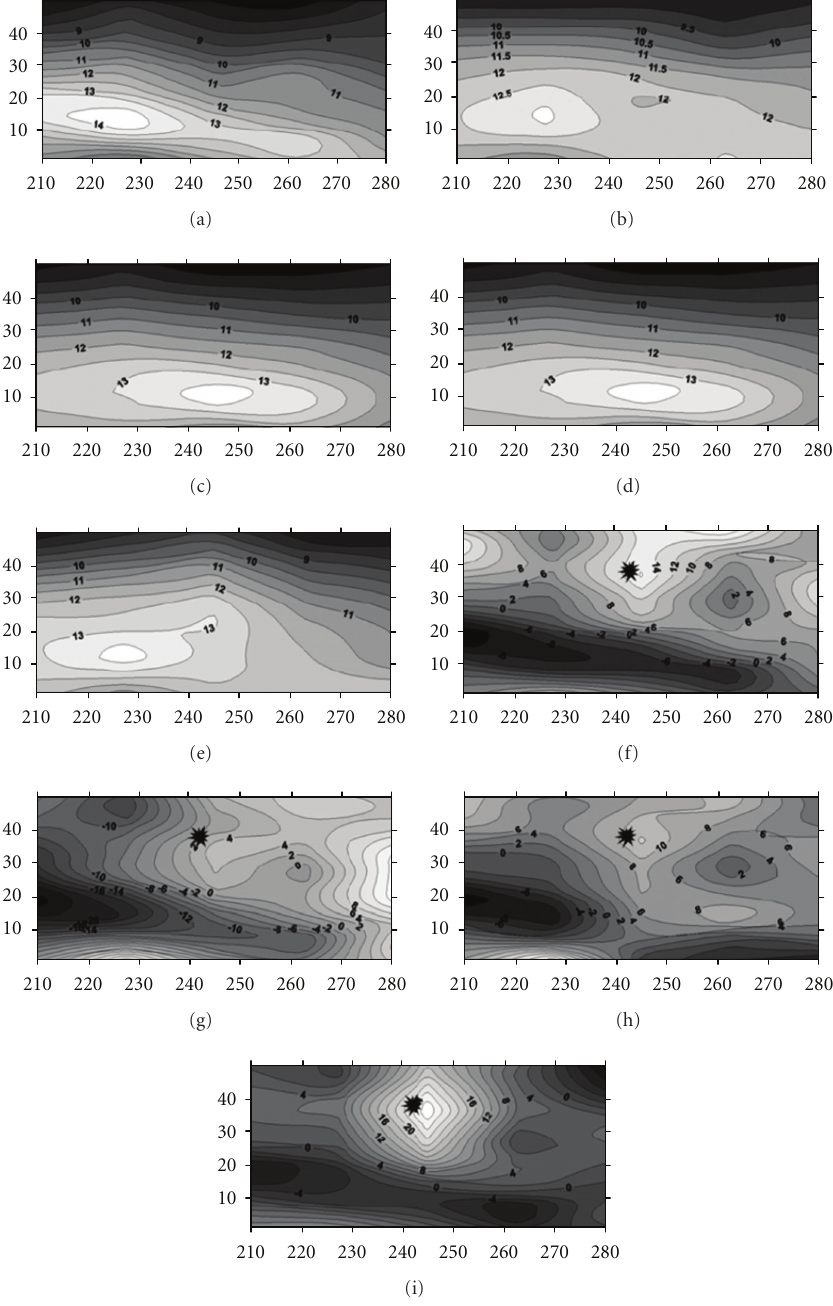
Figure 4: (a)–(e): absolute (foF2 distribution) LT maps for -15-16 LT. From (a) to (e): combined map for 15 and 19 May (undisturbed conditions, background level) and 21, 22, 26, and 27 of May. (f)–(i): the maps of the critical frequency deviation (in % relative to the top panel in the left column). From (f) to (i): 21, 22, 26, and 27 May. The epicenter position is shown by an